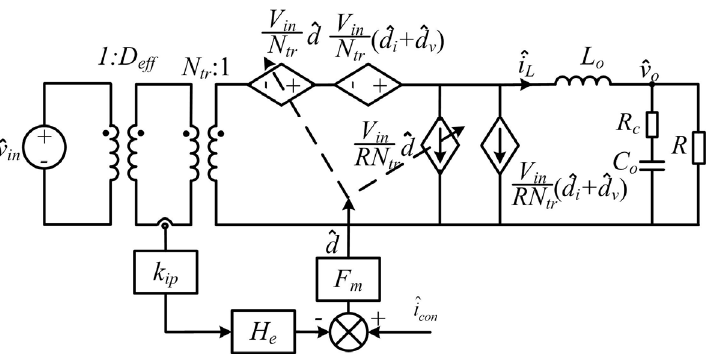
Figure 18. Small-signal circuit model of the converter with PCMC.